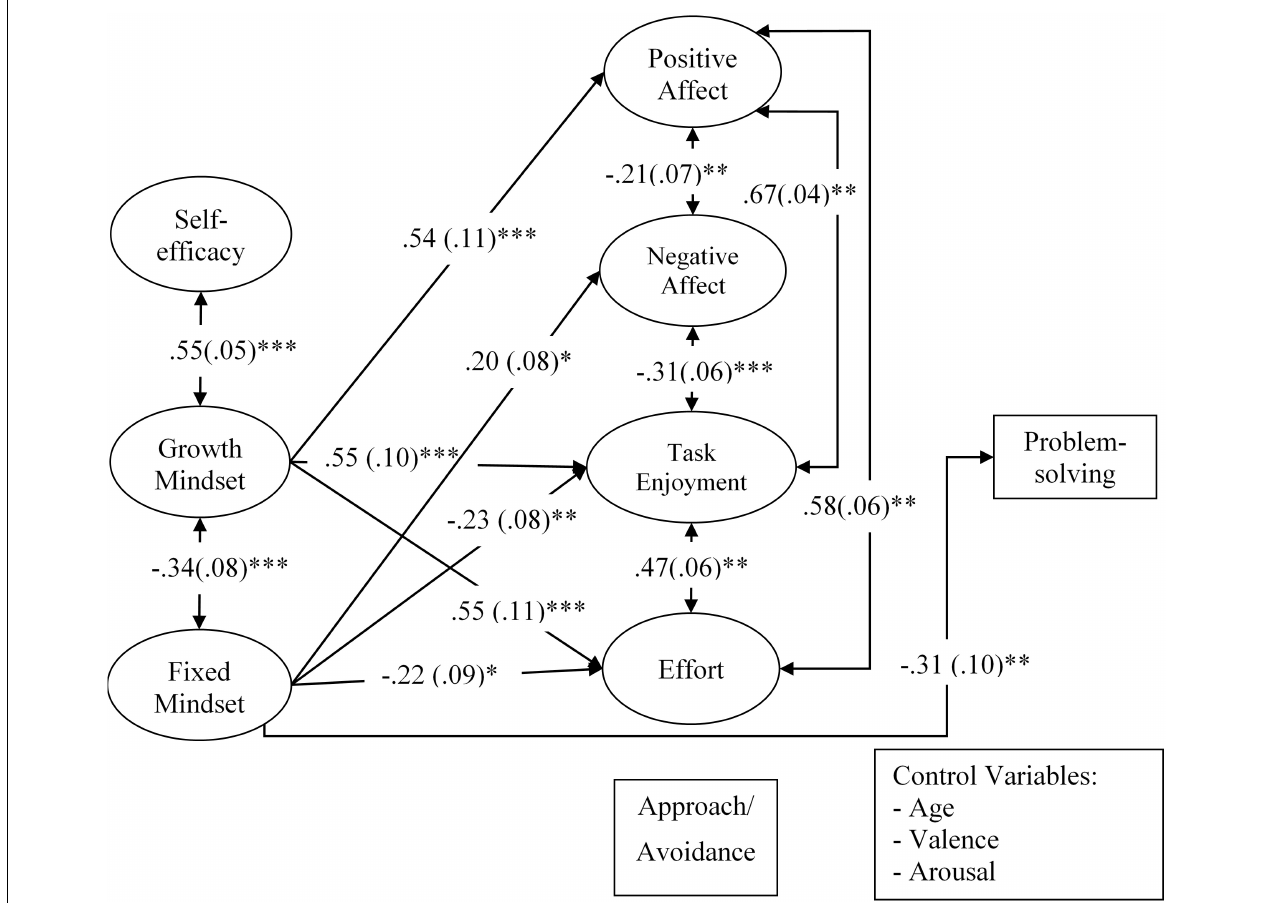
FIGURE 3 | The relationships between creativity as indicated by the problem-solving score and, creative self-efficacy and creative mindsets via self-regulatory responses while controlling the effects of age, valence and arousal (Model 5). For the sake of clarity, only significant direct paths are displayed. The values represent standardized path coefficients with standard errors in parentheses. ∗ p < 0.05, ∗∗ p < 0.01, ∗∗∗ p <